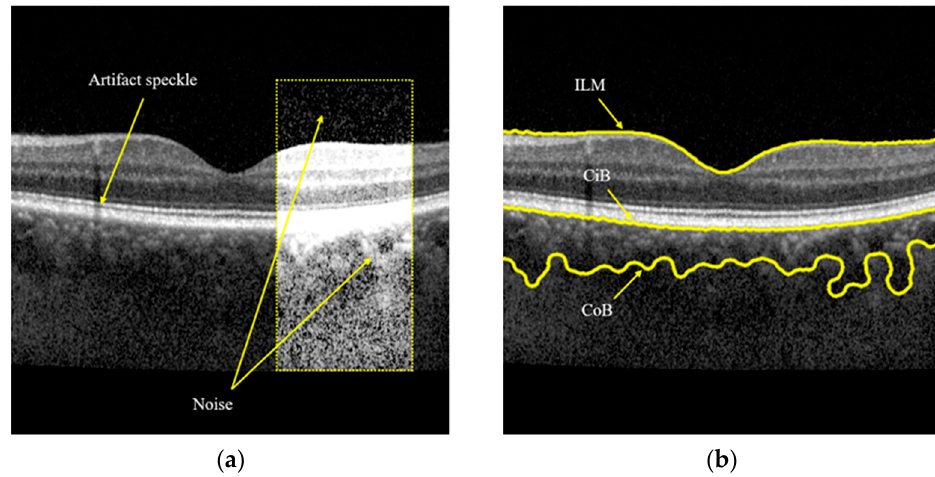
Figure 1. ( a ) An original OCT image with a contrast-enhanced area. ( b ) Location of the three desired layers, namely, the ILM, CiB, and CoB.